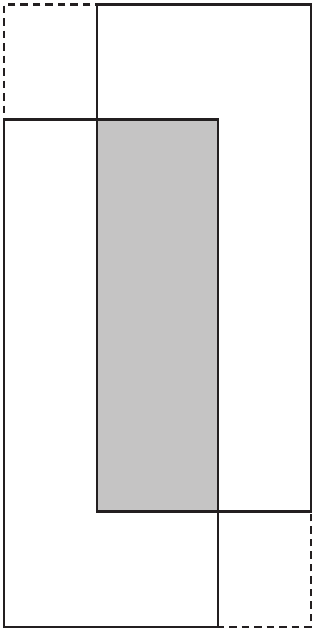
Figure 4: Illustration of GIoU metric. The solid line indicates the prediction box and ground truth box, the dotted line indicates the smallest enclosing box, and the shaded portion indicates the in- tersection of the prediction box and the ground truth